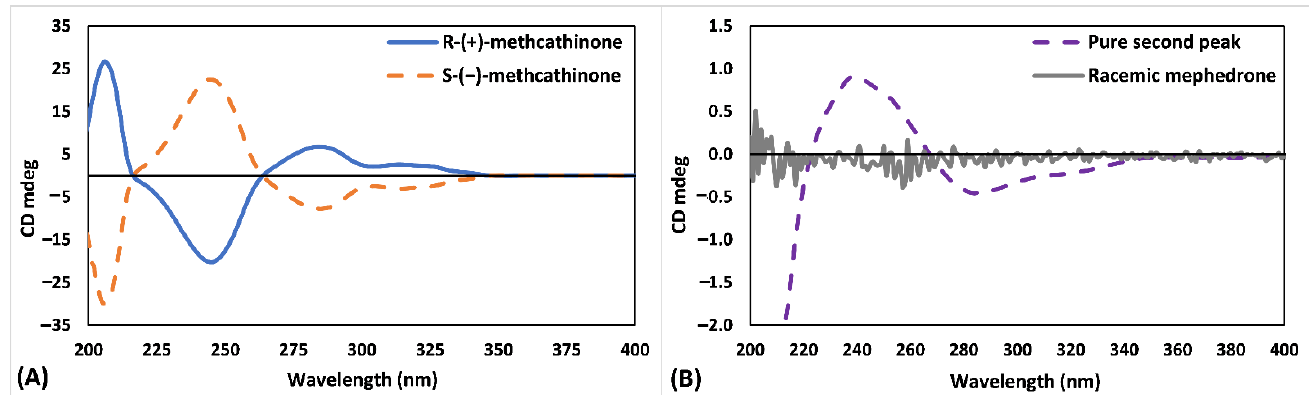
Figure 2. Circular dichroism profiles of ( A ) pure S-(−)-methcathinone and R-(+)-methcathinone and ( B ) racemic mephedrone and the second eluting peak from (±)-mephedrone samples (i.e., S-(−)-mephedrone).